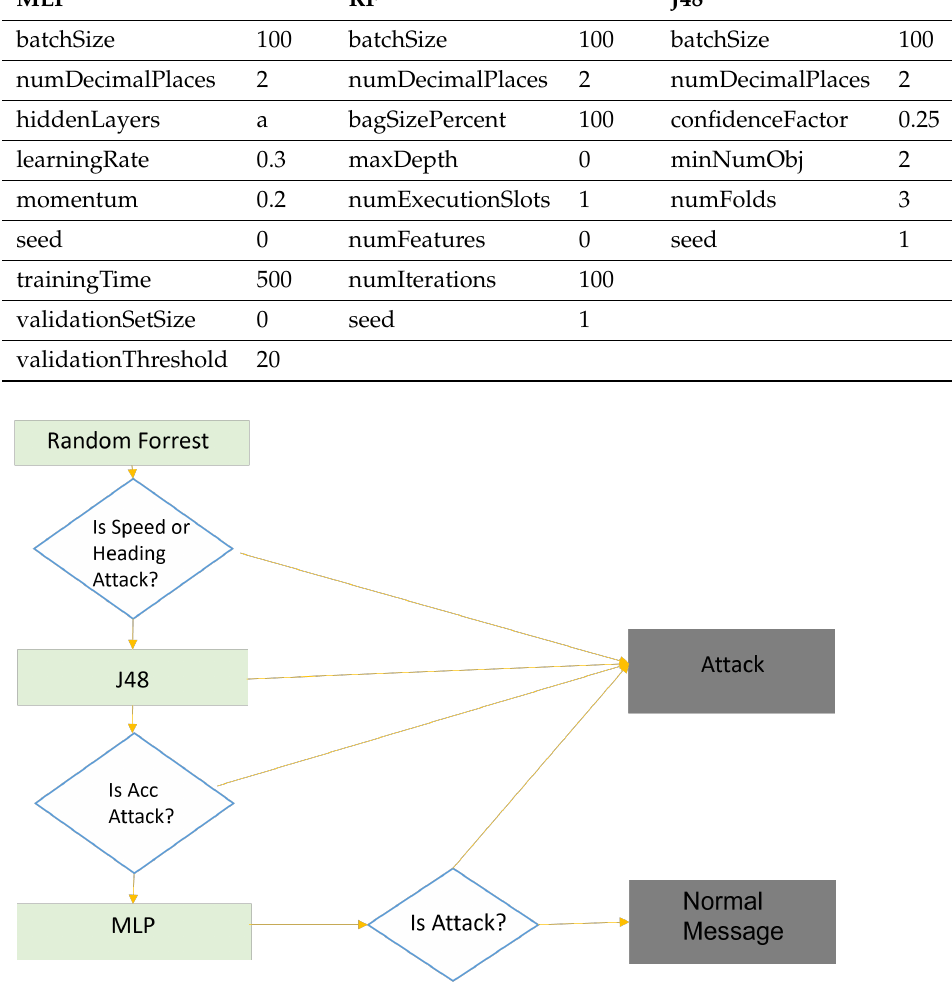
Figure 8. Custom Stacking Algorithm.